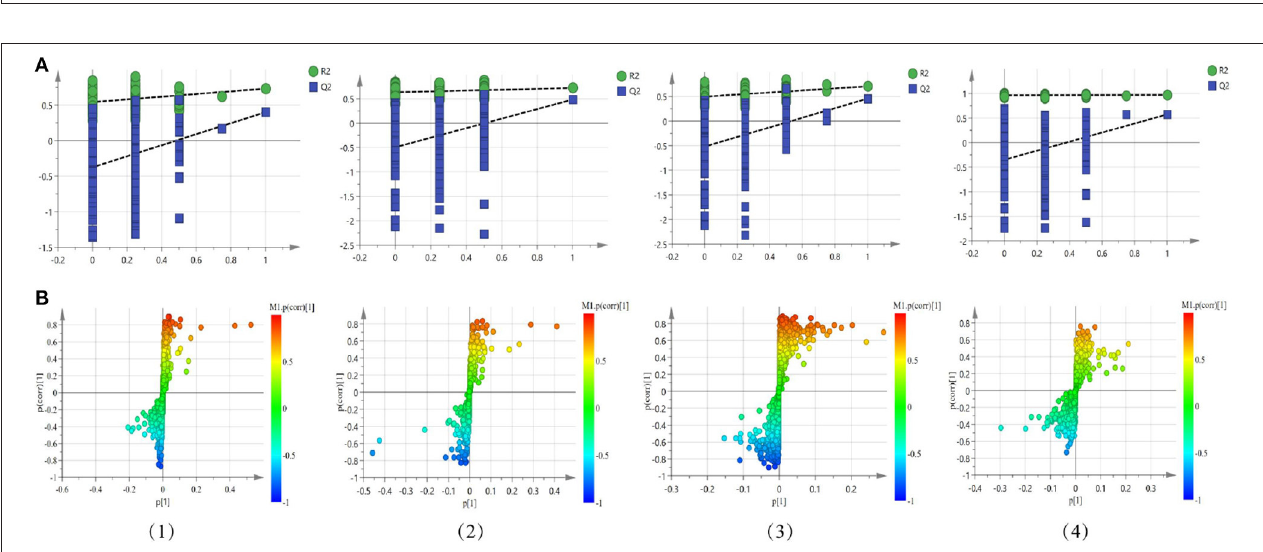
FIGURE 5 | The OPLS-DA score plots of the normal group and the model group in the positive mode of the non-polar part (A) and the positive mode of the polar part (B) of the serum, and in the positive mode of the non-polar part (C) and the positive mode of the polar part (D) of the cerebral cortex.